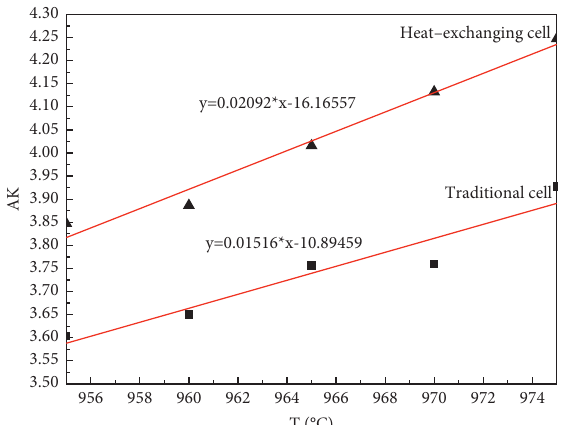
Figure 8: The relationships between ( A · K ) value and electrolyte temperature for the traditional cell and heat-exchanging cell, re- spectively (300 kA).